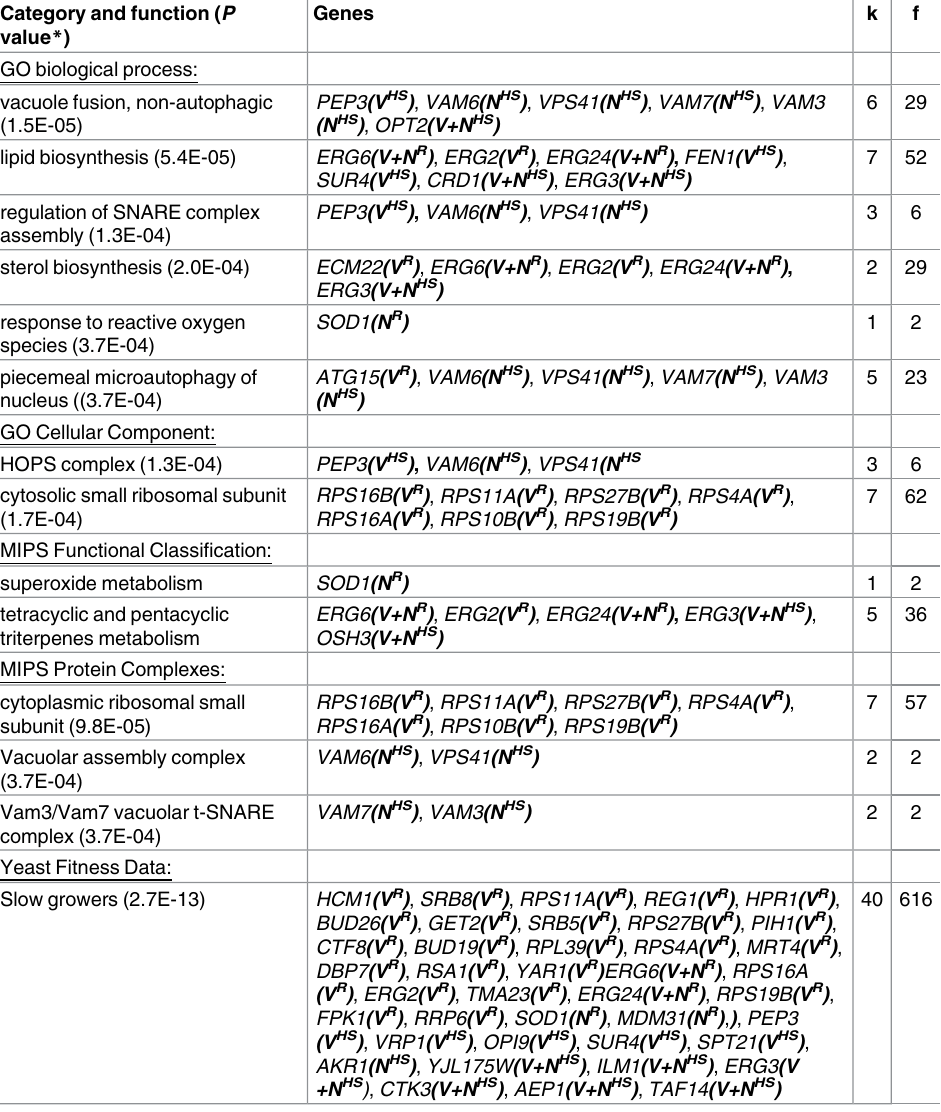
regulation of SNARE complex assembly (1.3E-04) sterol biosynthesis (2.0E-04) response to reactive oxygen species (3.7E-04)